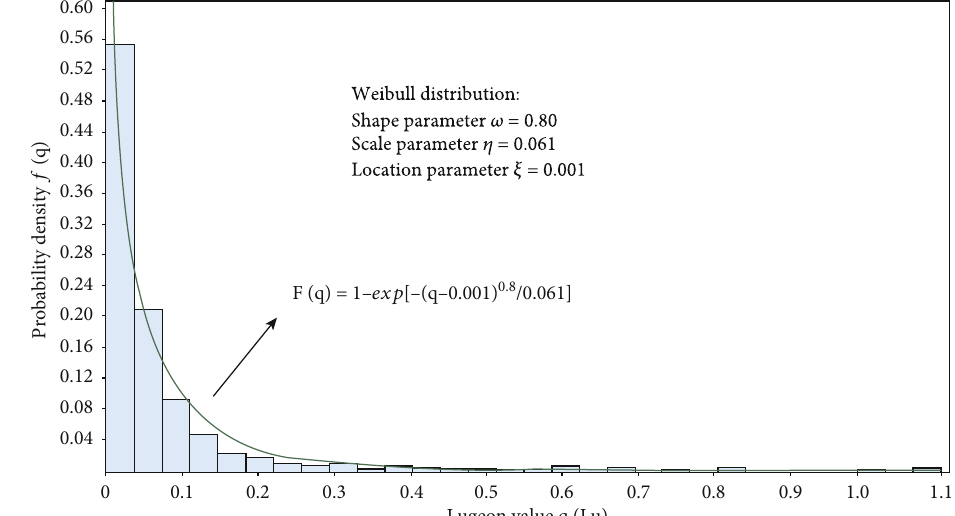
Figure 3: Distribution characteristics of Lugeon values in fresh or slightly weathered granite.